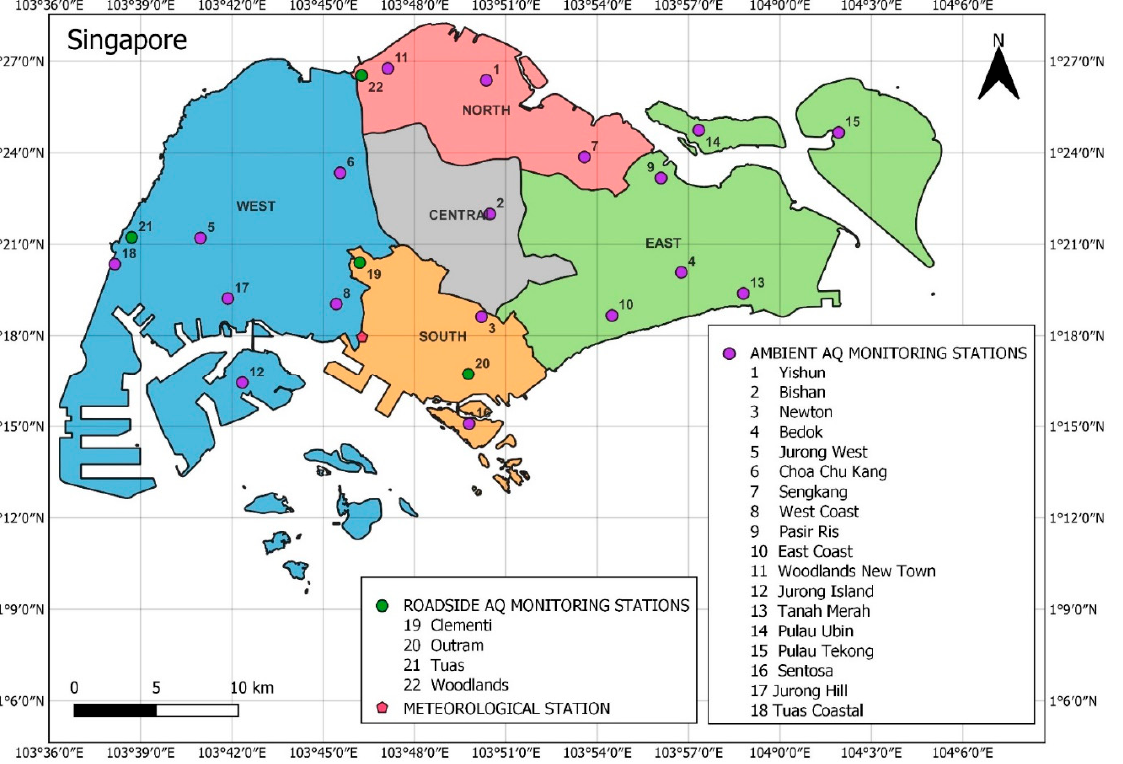
Figure 2. Locations of 22 air quality (AQ) monitoring stations (18 monitor general air quality and 4 monitor roadside air quality) across the five air quality regions and a meteorological station in the southern region in Singapore.